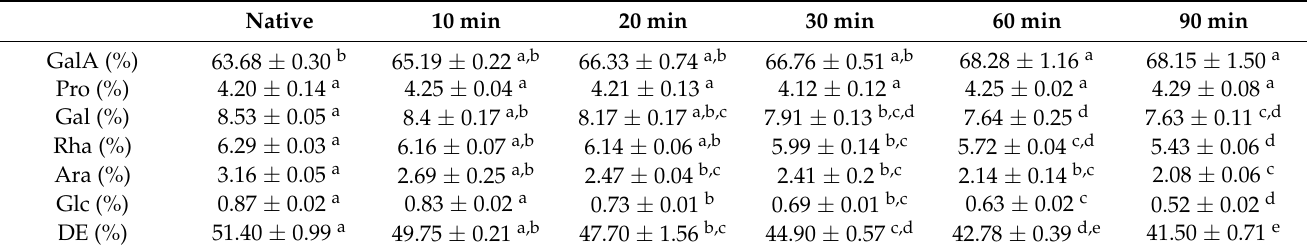
Table 1. Chemical composition of native SBP and its ultrasonic degradation